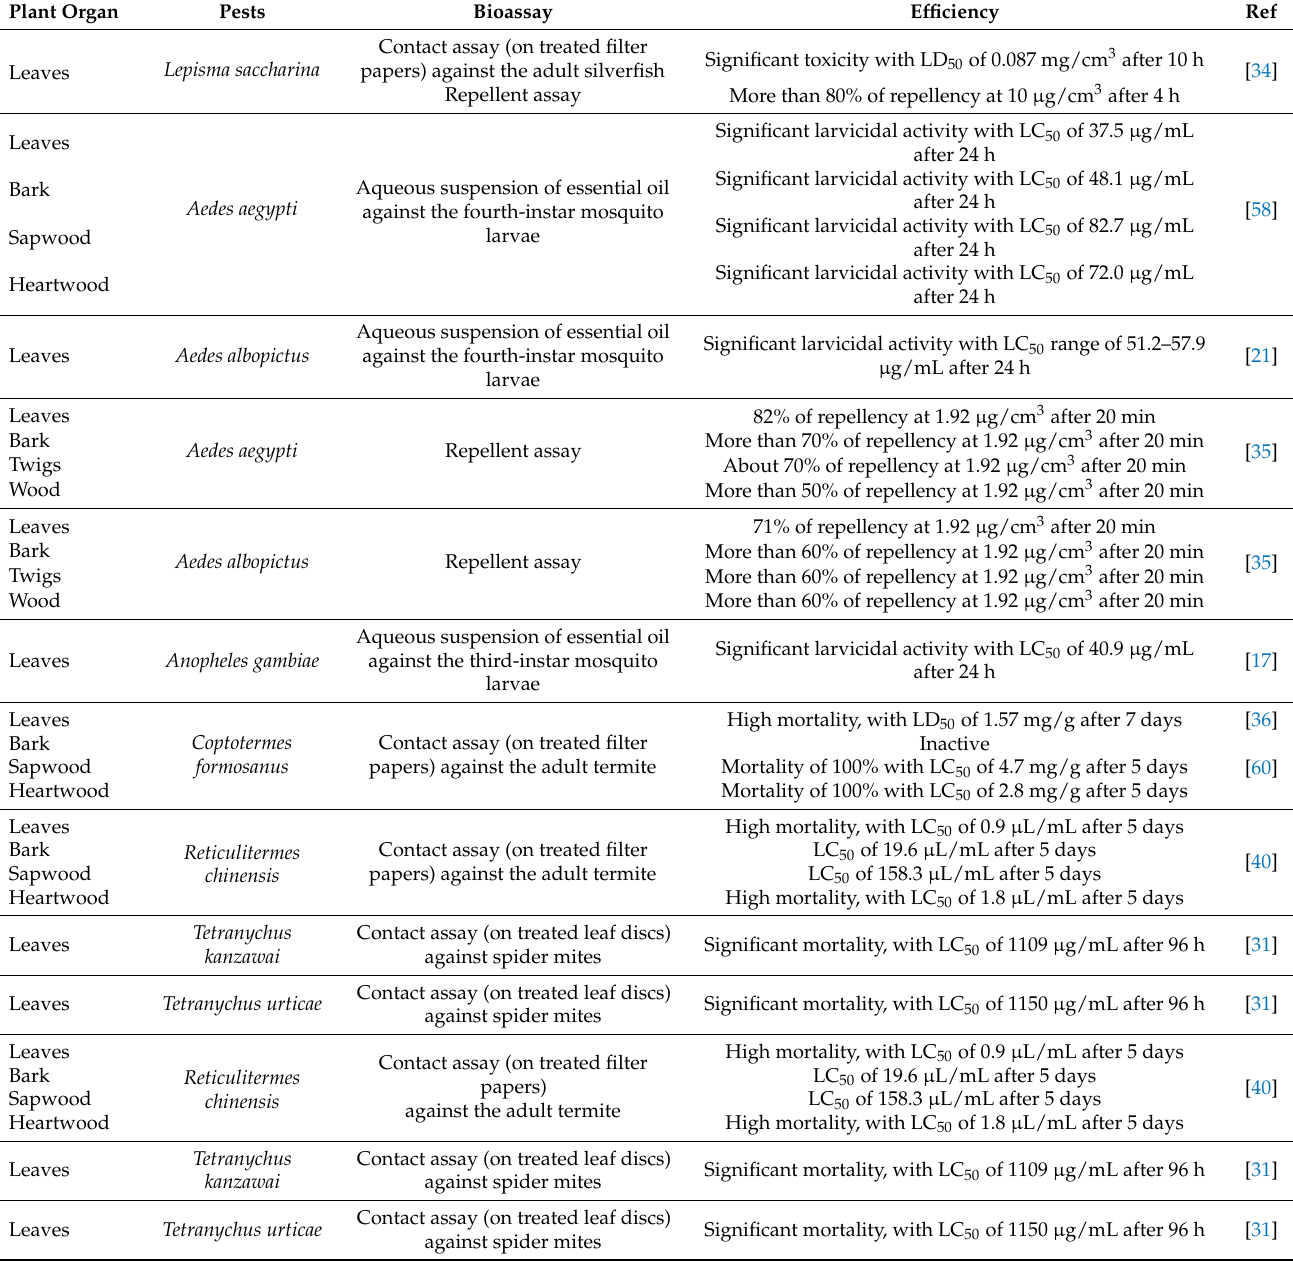
Table 4. Insecticidal and acaricidal activities of Cryptomeria japonica essential oil from different